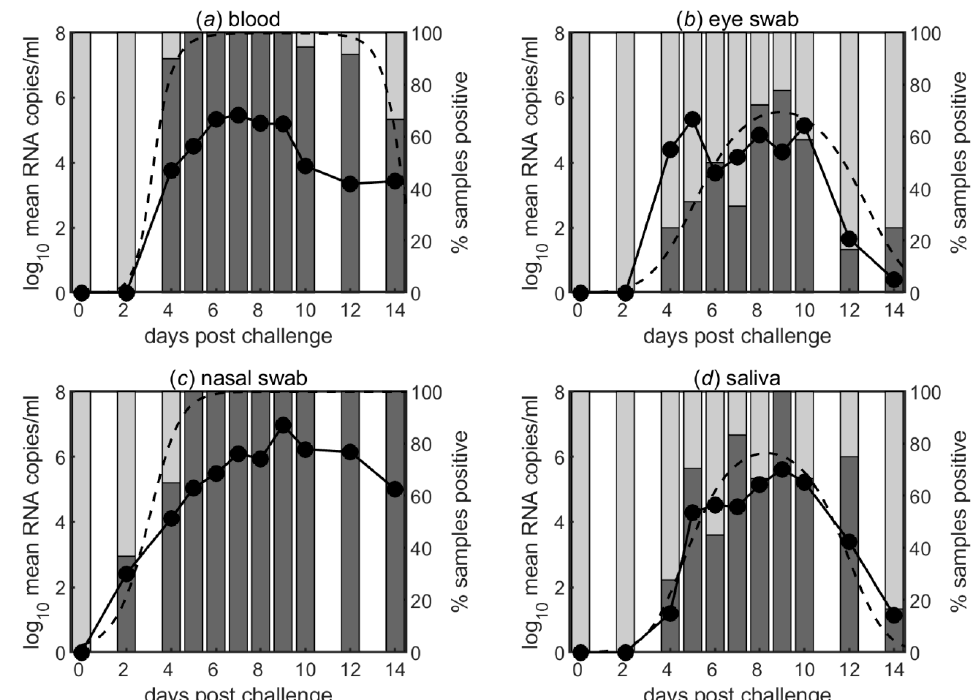
Figure 3. Mean levels of viral RNA (log 10 mean RNA copies/mL) in ( a ) blood, ( b ) eye swabs, ( c ) nasal swabs and ( d ) saliva swabs taken at different days post-challenge from goats infected with PPRV (left axis). The bars indicate the percentage of samples that were positive at each day post-challenge and the black dashed line indicates the model for the proportion of positive samples (right axis).